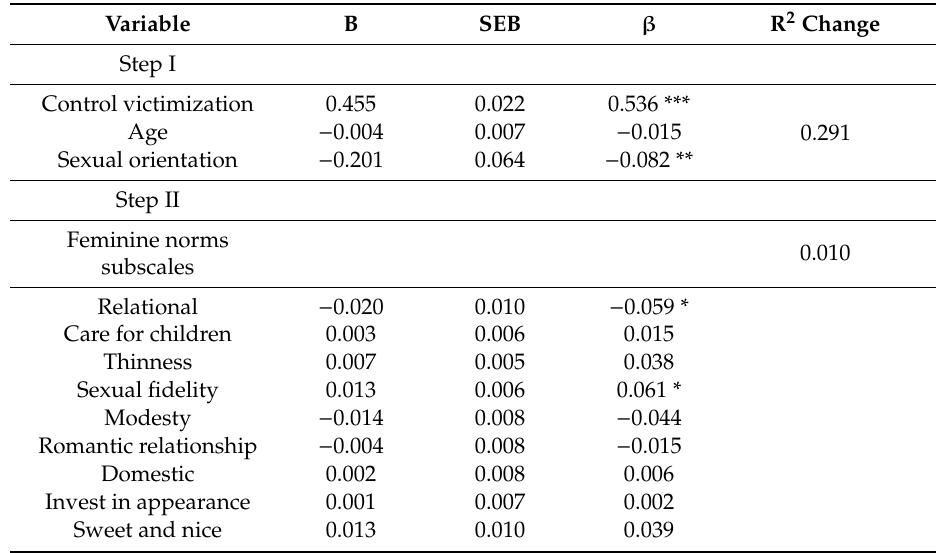
Table 4. Hierarchical regression analysis analyzing the association between feminine norms and control cyber dating